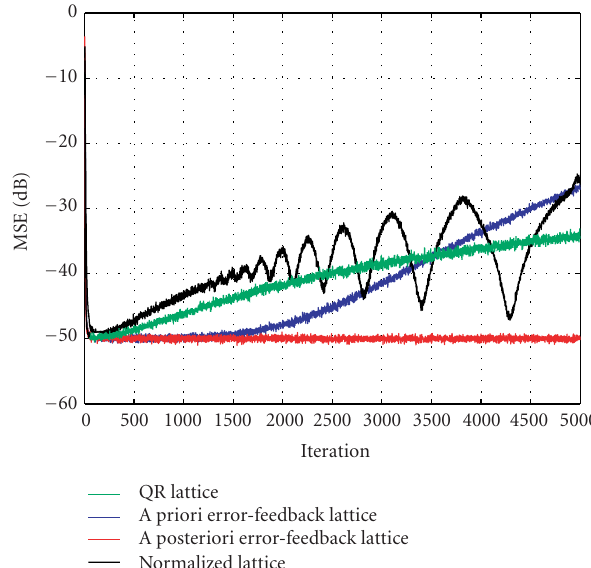
Figure 7: Performance of the algorithms for λ = 1, and 24-bit quantization.